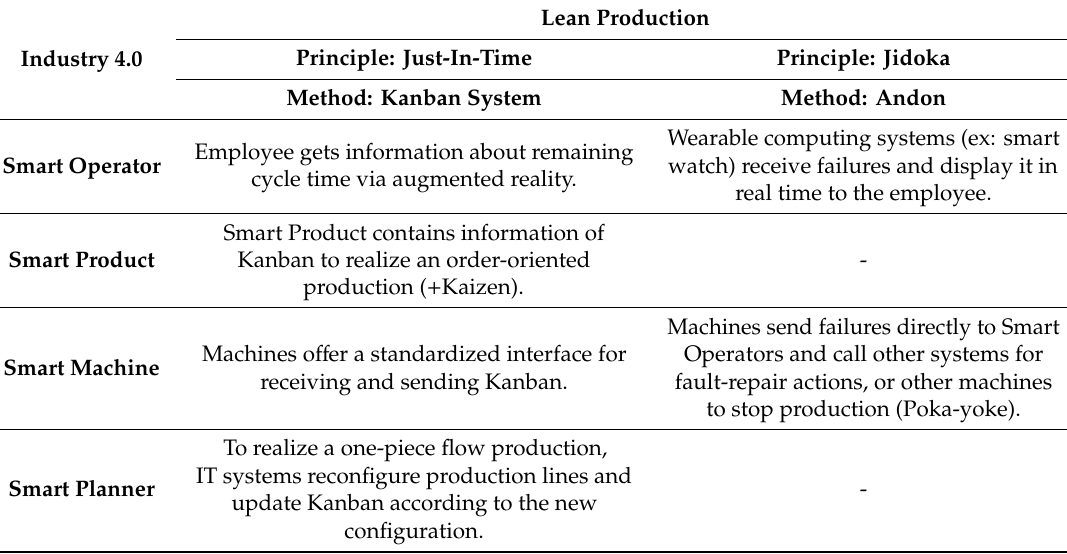
Table 1. Examples of use cases to combine Industry 4.0 with Lean